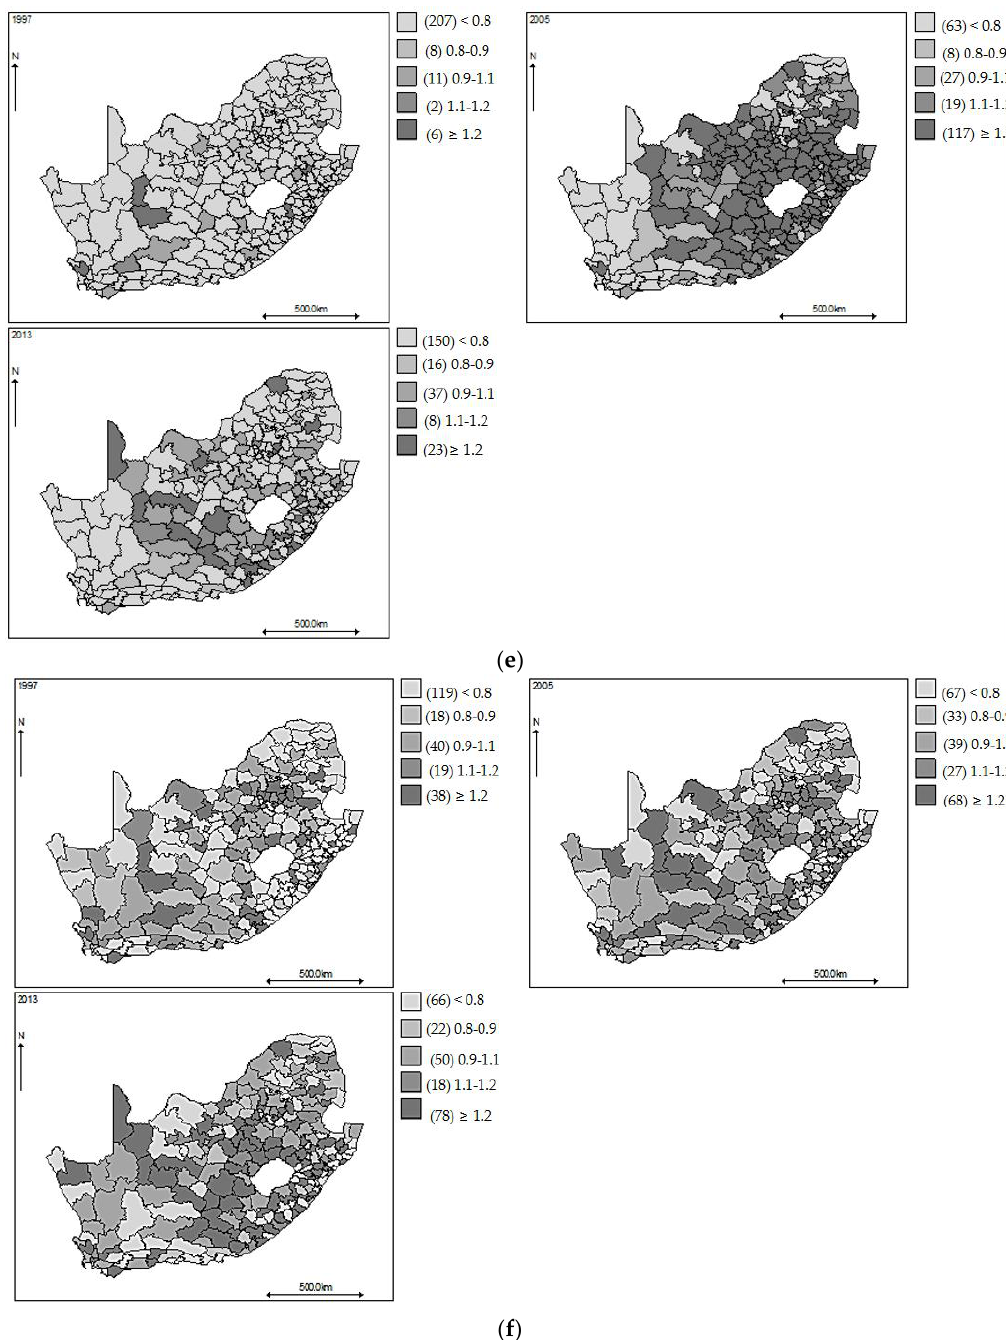
Figure 2. ( a ) Maps of municipality all-cause raw standardized mortality ratios for men aged 0 – 14 years in 1997, 2005, and 2013, South Africa; ( b ) Maps of municipality all-cause raw standardized mortality ratios for men aged 15 – 64 years in 1997, 2005, and 2013, South Africa; ( c ) Maps of municipality all-cause raw standardized mortality ratios for men aged 65 years or over in 1997, 2005, and 2013, South Africa; ( d ) Maps of municipality all-cause raw standardized mortality ratios for female aged 0 – 14 years in 1997, 2005, and 2013, South Africa; ( e ) Maps of municipality all-cause raw standardized mortality ratios for female aged 15 – 64 years in 1997, 2005, and 2013, South Africa; ( f ) Maps of municipality all-cause raw standardized mortality ratios for female aged 65 years or over in 1997, 2005, and 2013, South Africa.